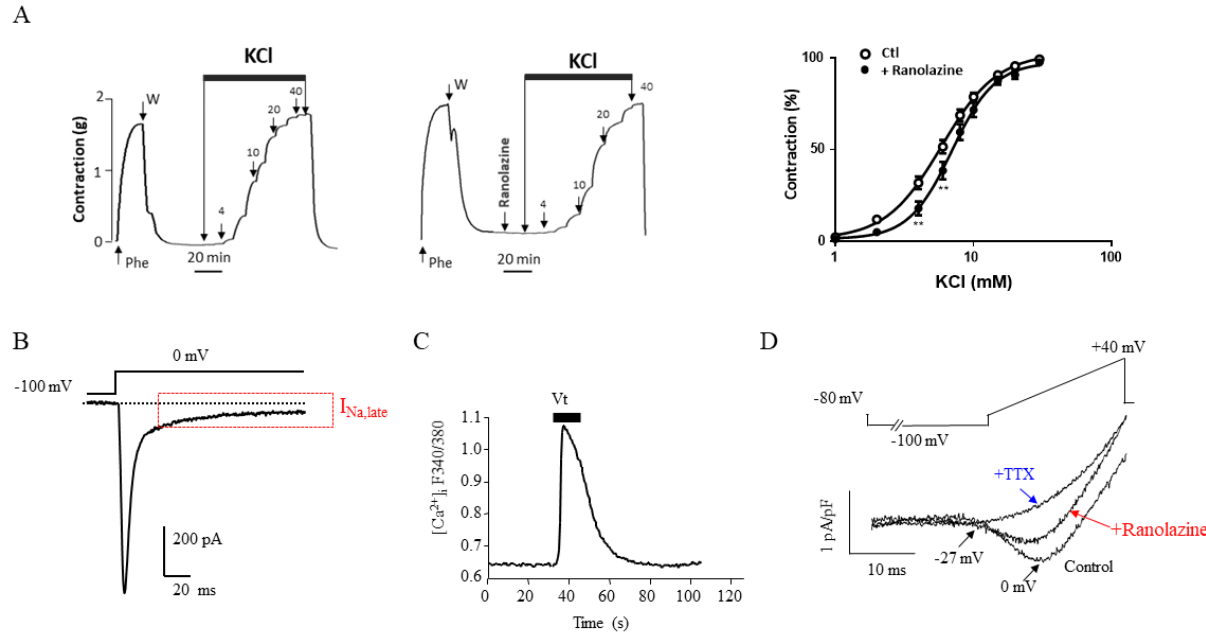
Figure 3. Voltage-gated Na + currents in arteries and effect of ranolazine. Effect of the addition of cumulative doses of KCl (1 to 40 mM) on a Na v channel-dependent component of contraction recorded in the absence ( left ) and the presence of ranolazine (20 µM) ( right ) in rat aortic rings . Graphs summarize the dose-response curves obtained for KCl. Averaged data expressed as percentage of the maximal contraction induced by KCl ( n = 15) ( A ). Reproduced from Figure 3B in [142]. ( B ) Typical Na + current with an I Na,late evoked at a test potential of 0 mV from a holding potential of − 100 mV, using the whole-cell patch-clamp technique, in a primary cultured human coronary myocyte (HCM) (unpublished personal data). The experiment was performed as described [161]. ( C ) Increas- ing effect of the Na + channel agonist veratridine (Vt; 10 µM) on intracellular Ca 2+ ([Ca 2+ ] i ) in a fura- 2–loaded HCM (unpublished personal data). The experiment was performed as described in [162].